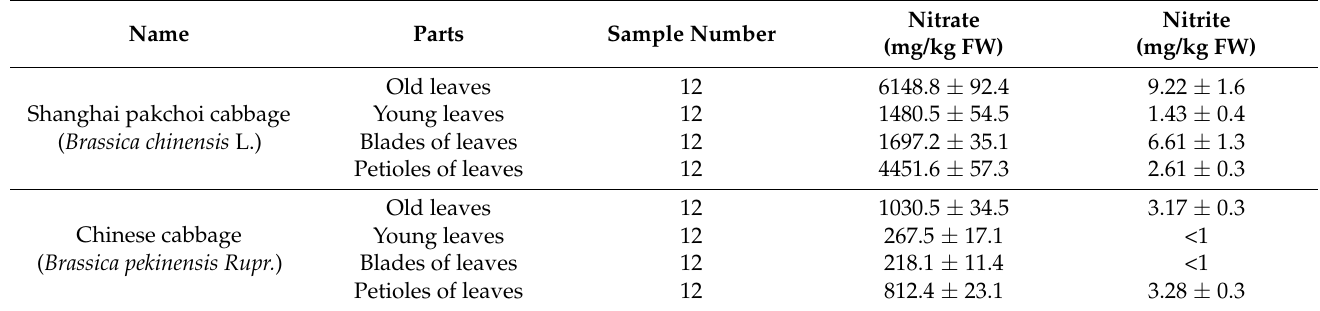
Table 7. Content of nitrate and nitrite in the different parts of leaves of Shanghai pakchoi cabbage ( Brassica chinensis L.) and Chinese cabbage ( Brassica pekinensis Rupr.